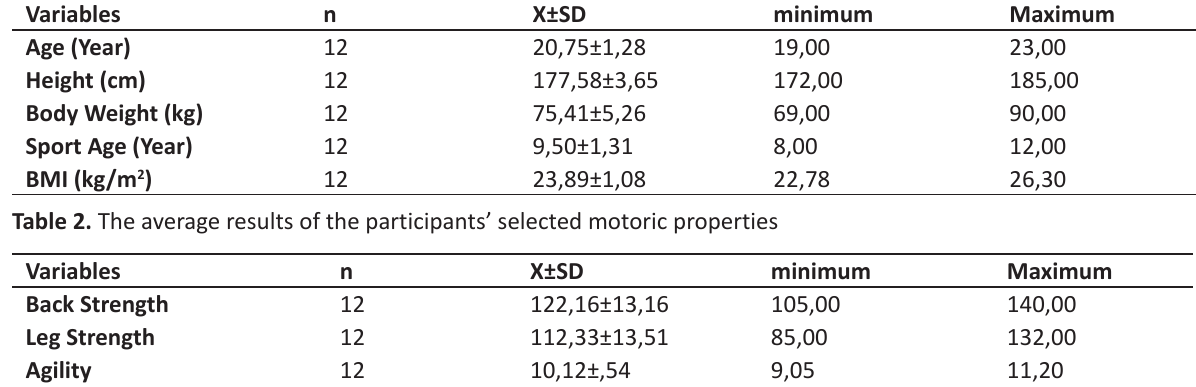
Table 1. The Demographic Characteristics of the Participants Variables